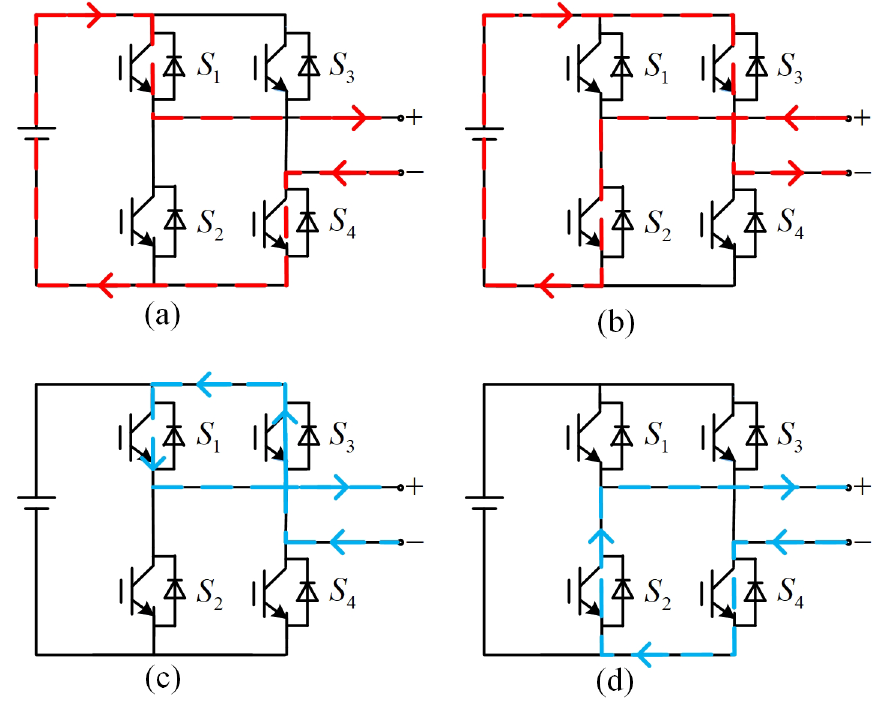
Figure 1. Four working states of the H-bridge: ( a ) forward conduction; ( b ) reverse conduction; ( c ) forward bypass; ( d ) reverse